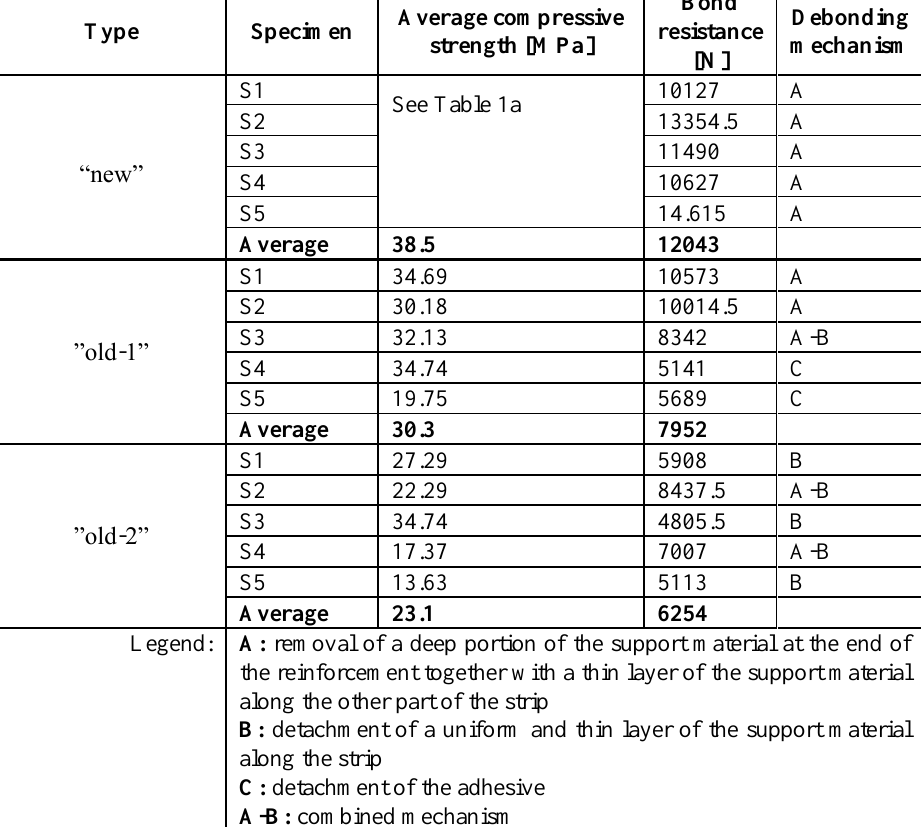
Table 2. Compressive test results (old bricks) and bond tests results (new and old